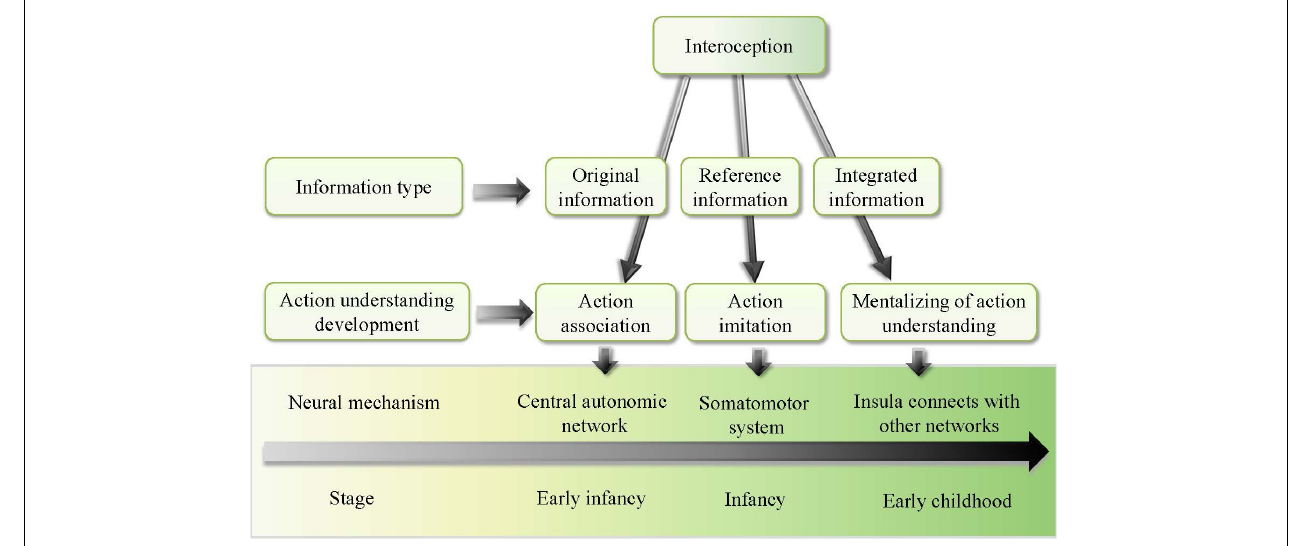
FIGURE 1 | Developmental model of action understanding of children promoted by interoception.